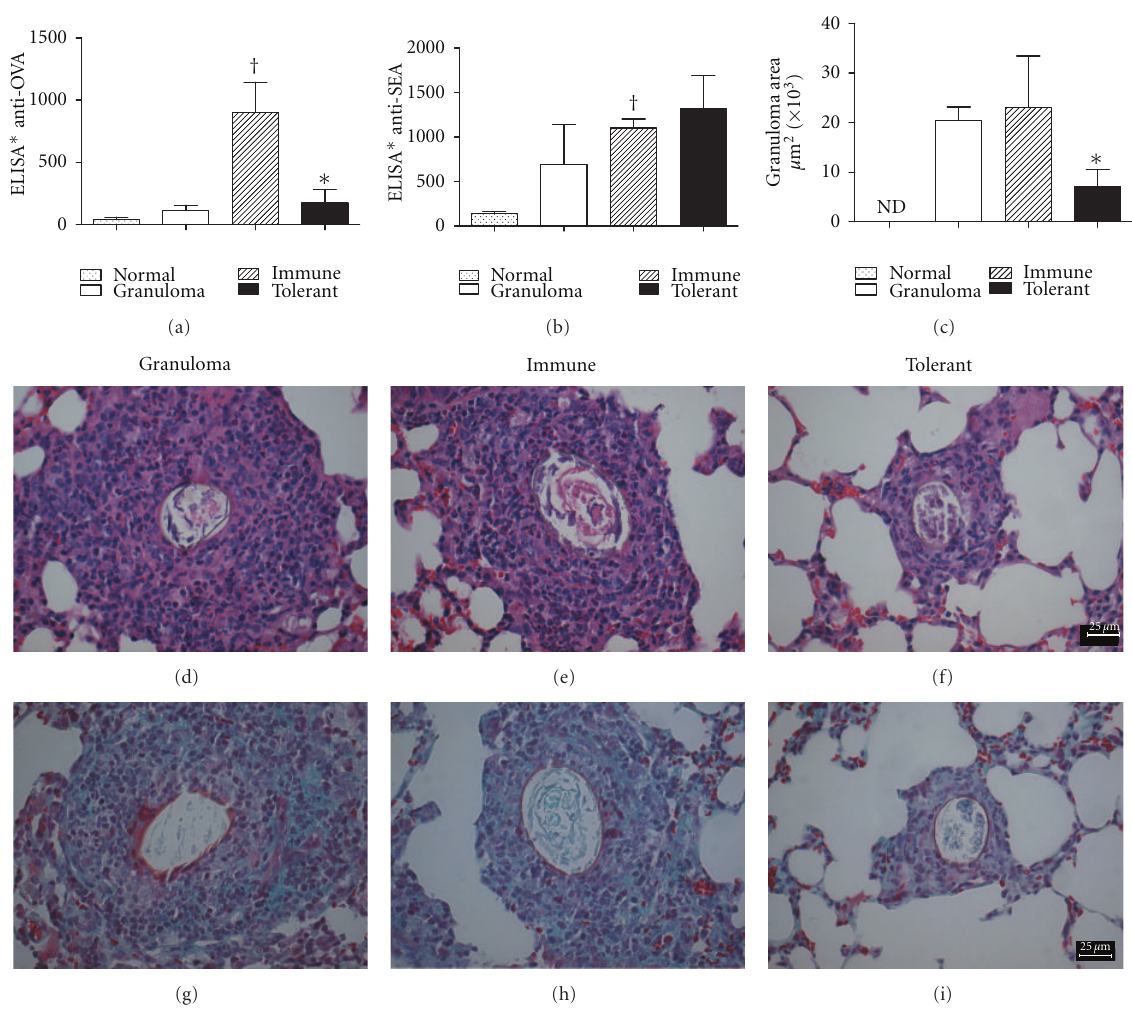
Figure 1: Reduction of granuloma by re-exposure of orally tolerant animals to the tolerated antigen. Serum levels of (a) anti-OVA antibodies and (b) anti-SEA antibodies and (c) pulmonary granuloma area and (d–i) histological aspect of pulmonary granuloma 18 days after i.v. injection of S. mansoni eggs in nonimmunized mice (granuloma group, open bars), OVA immune controls (hatched bars), and OVA-orally tolerant (black bars). Normal mice (doted bars) were not immunized with OVA neither injected with eggs. Data represent mean ± SEM. ∗ P ≤ 0 . 05 tolerant versus immune † P ≤ 0 . 05 immune versus normal. nd: not detected. Original magnification of HE (d–f) and Gomori’s trichrome (g–i) photomicrographs 400X; scale bars = 25 μ